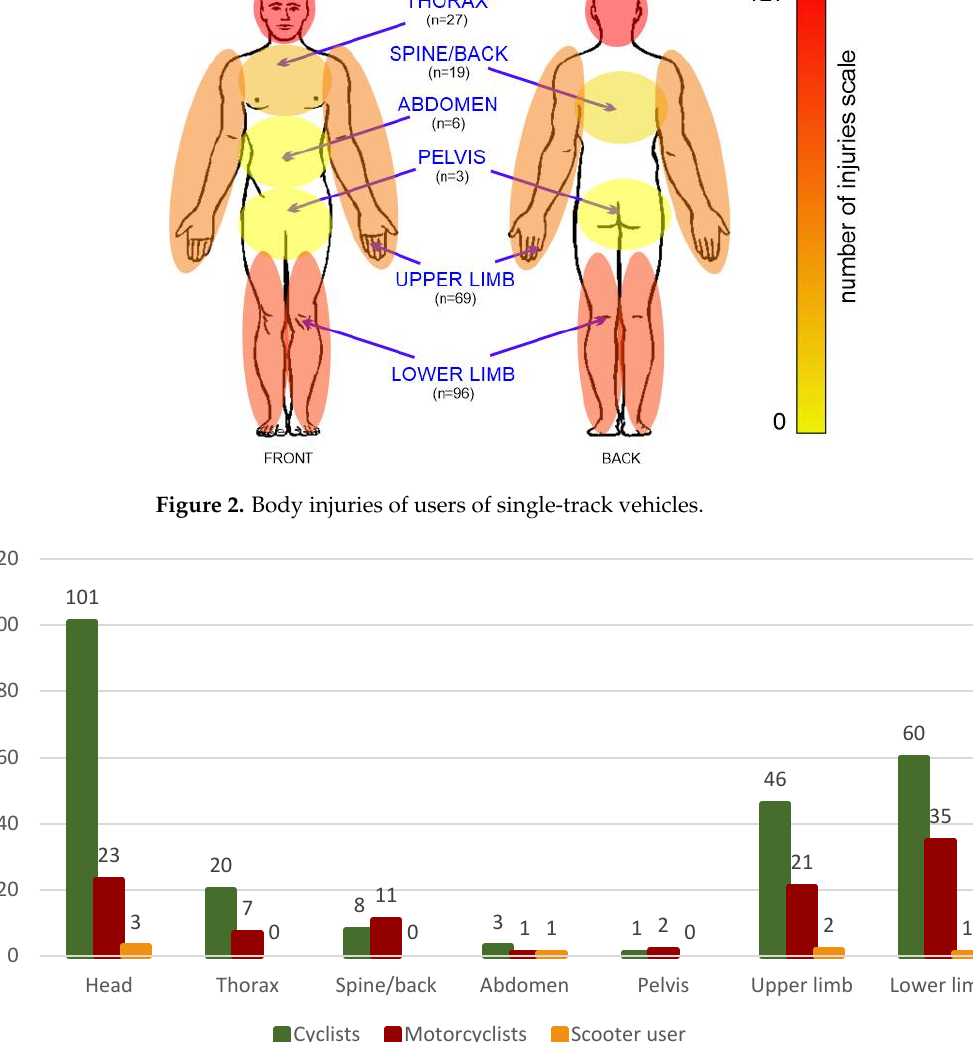
Figure 2. Body injuries of users of single-track vehicles.